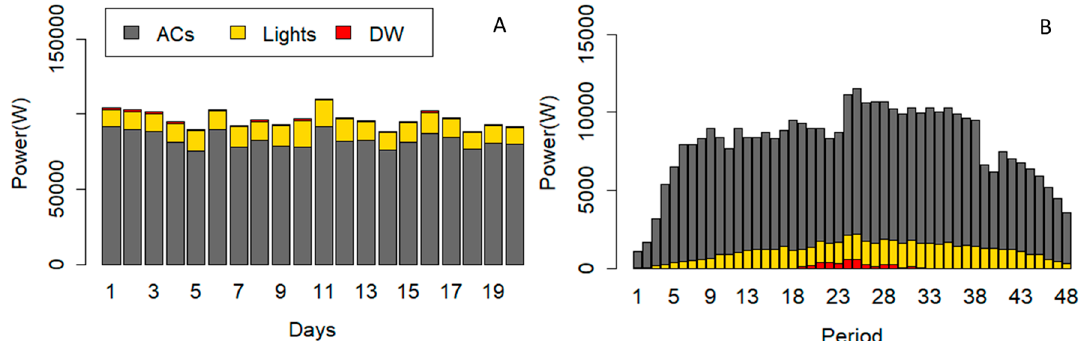
Figure 14. Power consumption of the devices after optimization in Scenario 6. ( A ) indicates the power consumption of devices on each day, and ( B ) shows the average power consumption of devices in each period.